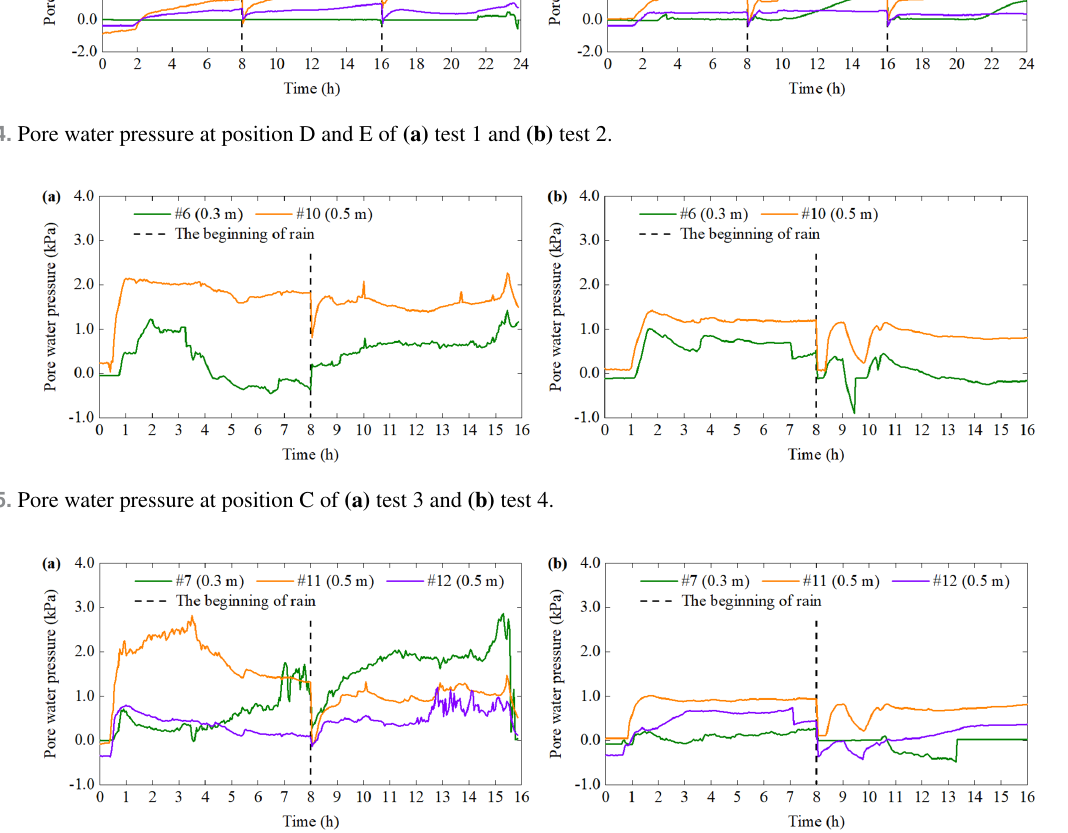
Figure 16. Pore water pressure at position D and E of (a) test 3 and (b) test